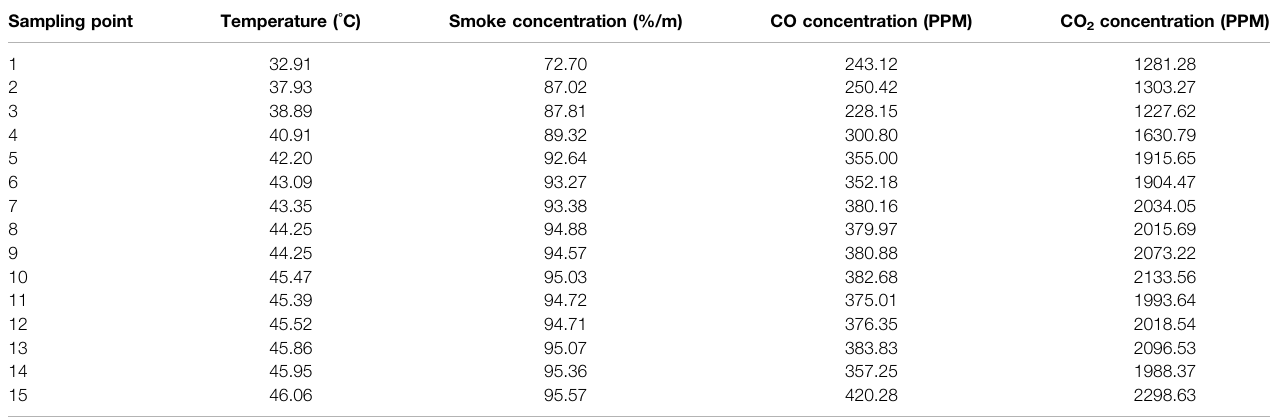
TABLE 4 | Partial sampling data (300 kW, lower